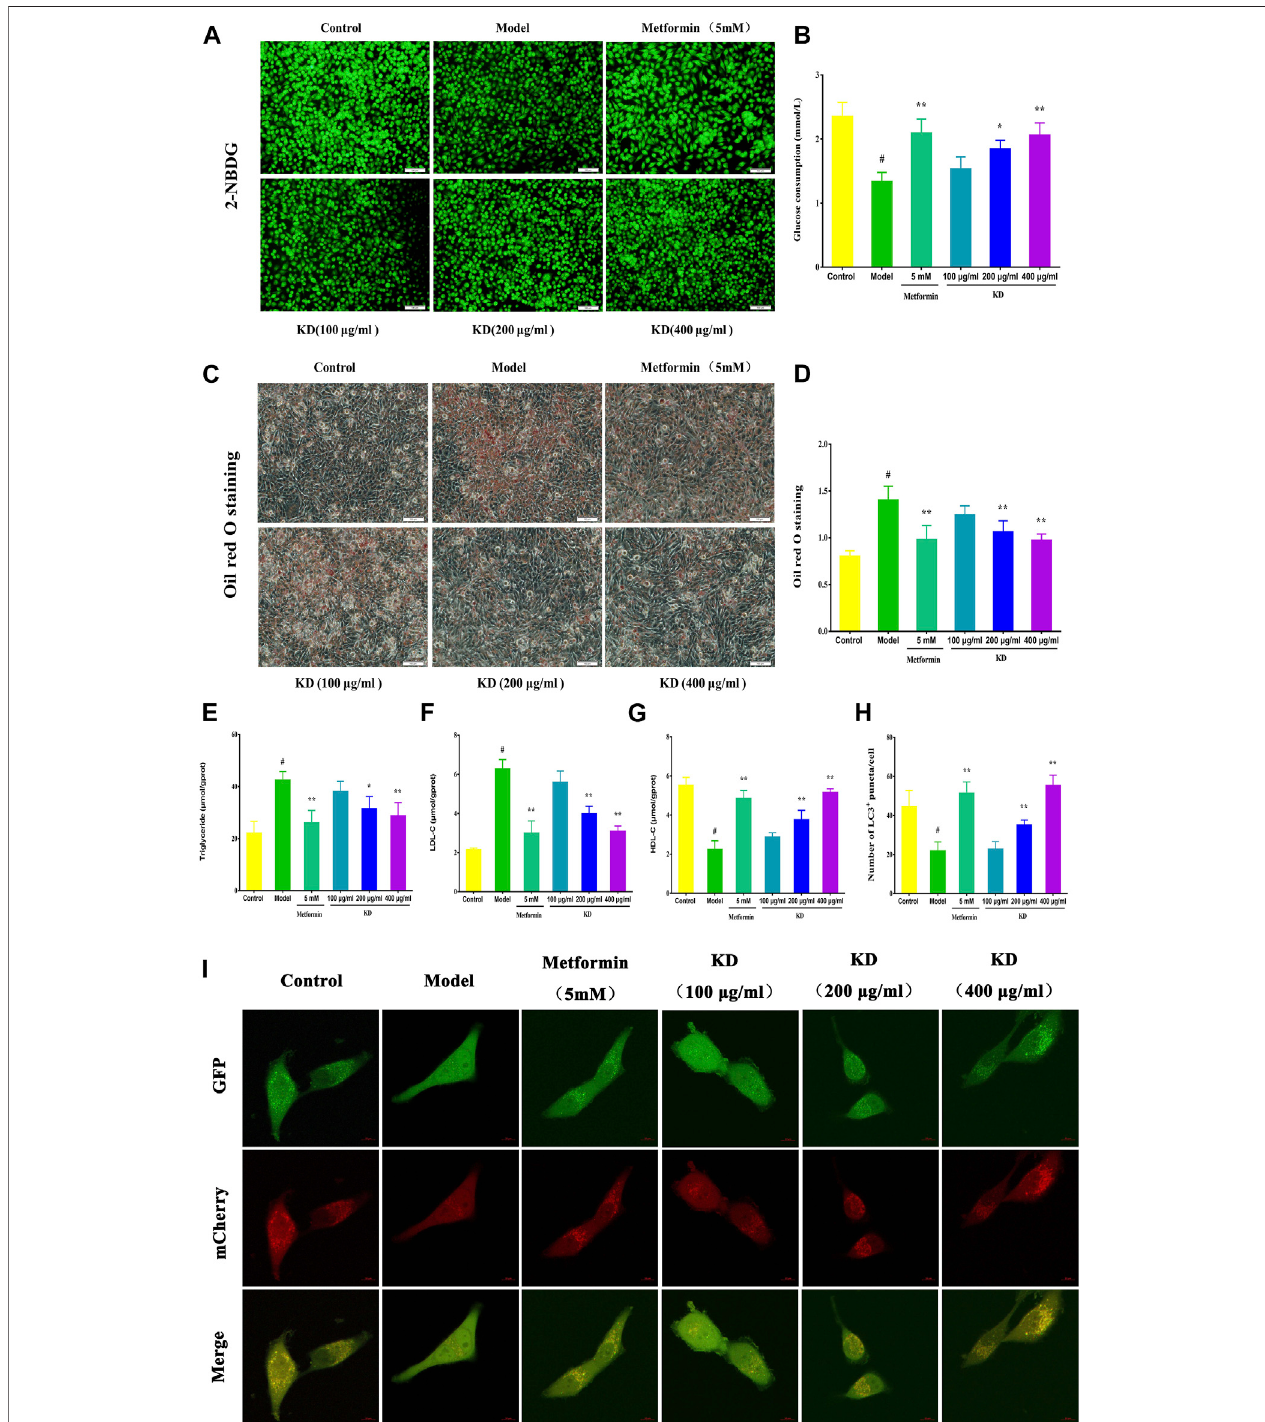
FIGURE 4 | KDactivateshepaticautophagytoimprovetheglucoseandlipidmetabolisminLO2cells.LO2cellswereincubatedinDMEMwith0.5%fattyacid-freeBSAor oleicacid(0.25 mM)inthepresenceofKD(100,200and400 μ g/ml)ormetformin(5 mM)for24 h.2-NBDGandglucoseoxidaseandperoxidaseassaywereusedtoanalyzethe glucose uptake (A) and consumption (B) of oleic acid-induced LO2 cells. Oil red O staining was performed to evaluate the lipid accumulation of insulin-resistant cells (C,D) . Intercellular triglyceride (E) , LDL-C (F) and HDL-C (G) were also determined to assess the lipid metabolism of insulin-resistant cells. (I) Then LO2 cells were infected with adenoviruses expressing mRFP-GFP-tagged LC3. All images were acquired by a confocal laser microscope. (H) Autophagy fl ux was assessed by the number of mRFP + /GFP + (yellow)andmRFP + /GFP - (red)punctaincells.Yellowpunctarepresentsautophagosomesandredpunctarepresentsautolysosomes.Datawerepresentedasmean ± SD( n (cid:2) 3 in each group). # P < 0.01 compared with the control group, * P < 0.05, ** P < 0.01 compared with the model group.